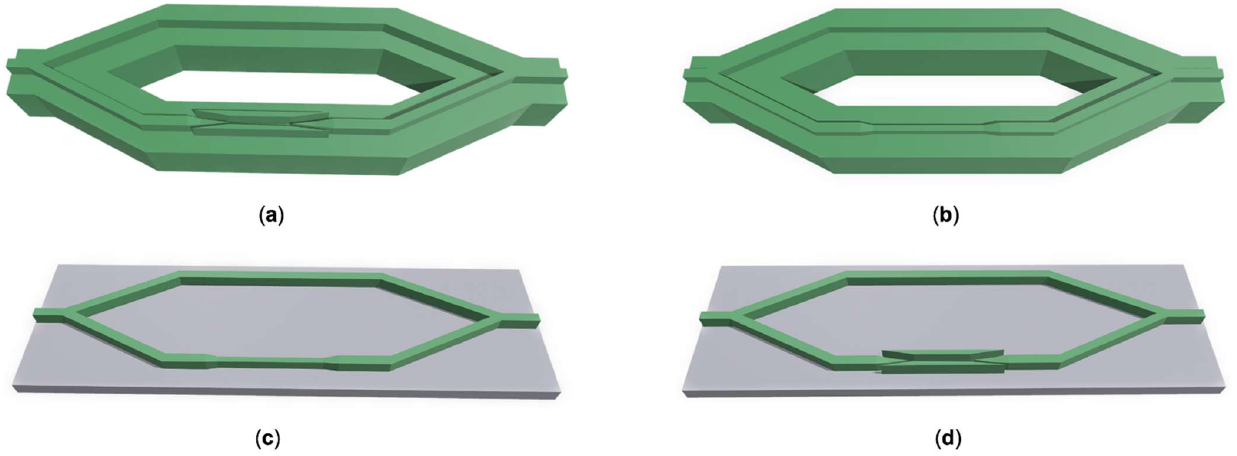
Figure 6. Schematics of the devices: ( a ) the suspended MZI with a slot waveguide; ( b ) the suspended MZI with a strip waveguide; ( c ) the MZI with a strip waveguide on a substrate; and ( d ) the MZI with a slot waveguide on a substrate.